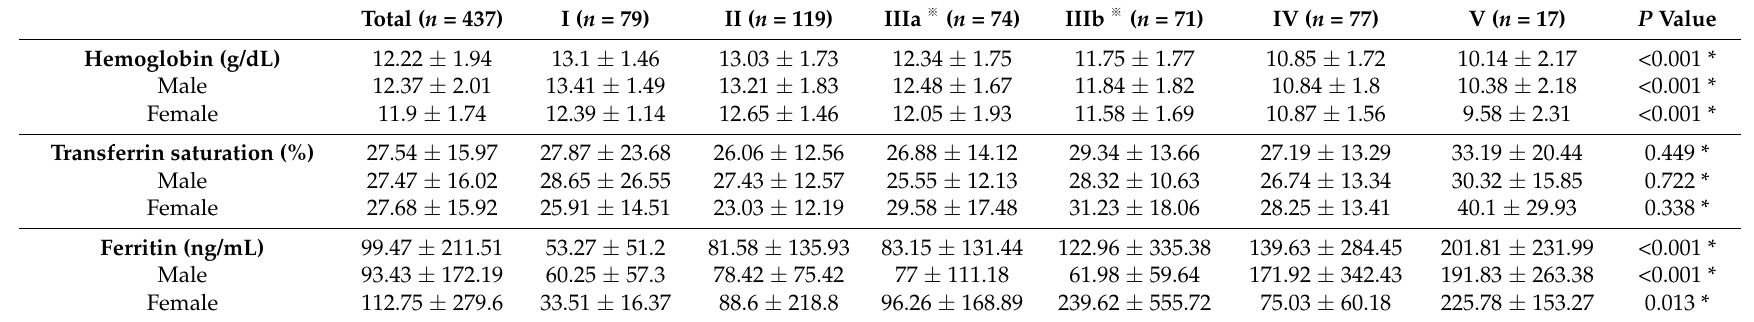
Numerical values are reported as n (%); CKD, chronic kidney disease; n, number of patients. * More detailed data are described in supplementary Table S1; ※ CKD stage III is divided into subgroup stage IIIa and IIIb according to the eGFR (estimated glomerular filtration rate), stage IIIa is an eGFR between 45 and 59 and Stage 3b is an eGFR between 30 and 44; † Disease duration refers to the years between the date of the baseline data collection and the CKD diagnosis date; ‡ Duration of aggravated renal function means the years between the date of the baseline data collection and the date of onset of the preceding disease to